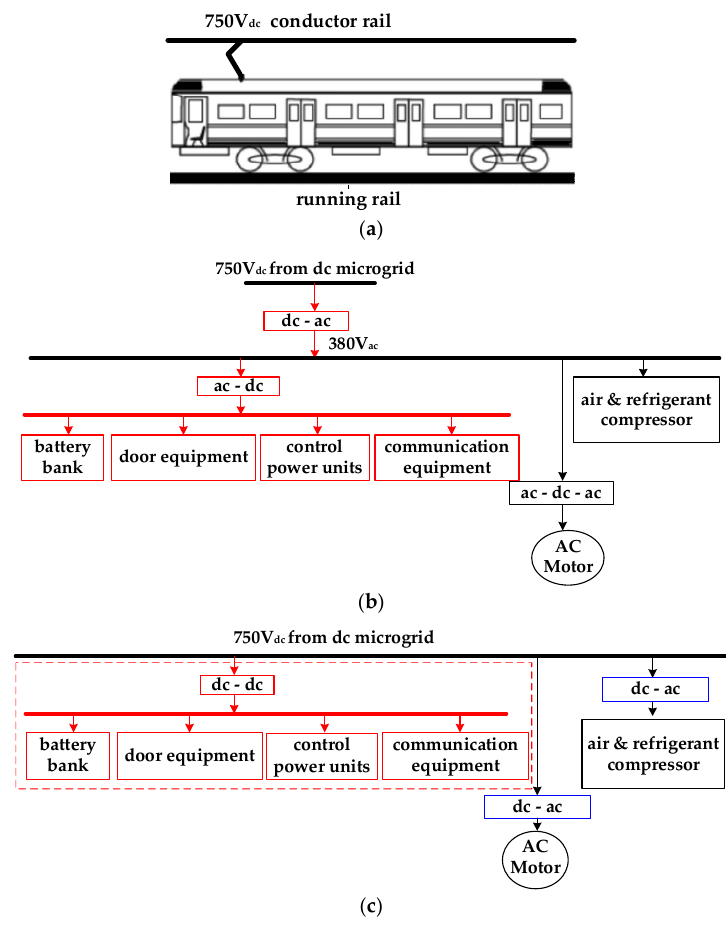
Figure 2. Basic blocks of light rail transportation vehicle ( a ) light rail vehicle; ( b ) distributed power in conventional vehicle; ( c ) distributed power in the studied case.